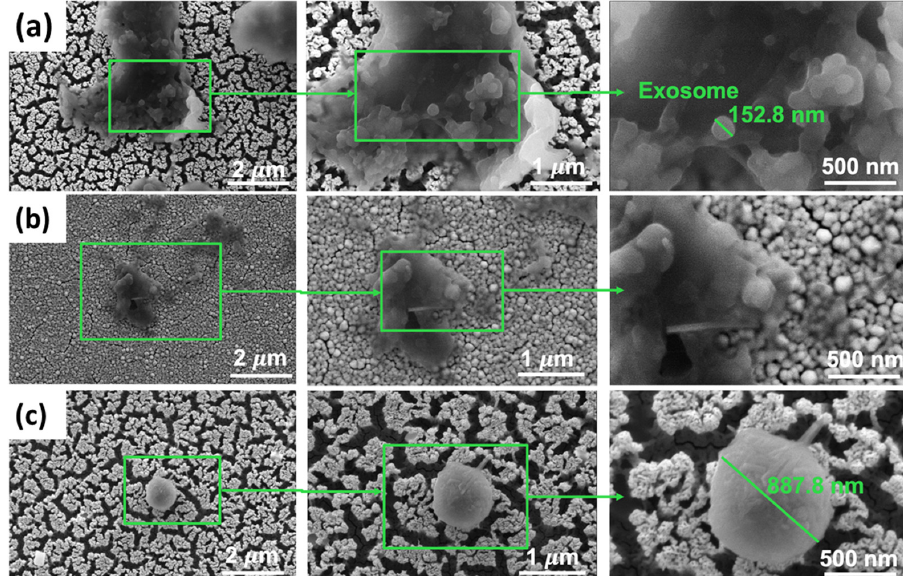
Figure 6. SEM Results of gold substrates functionalization: ( a ) Porous gold substrates functionalized with exosomes, ( b ) Nonporous gold substrates functionalized with exosomes (Reference), ( c ) Porous gold substrates functionalized with exosomes with different antibodies (Control).